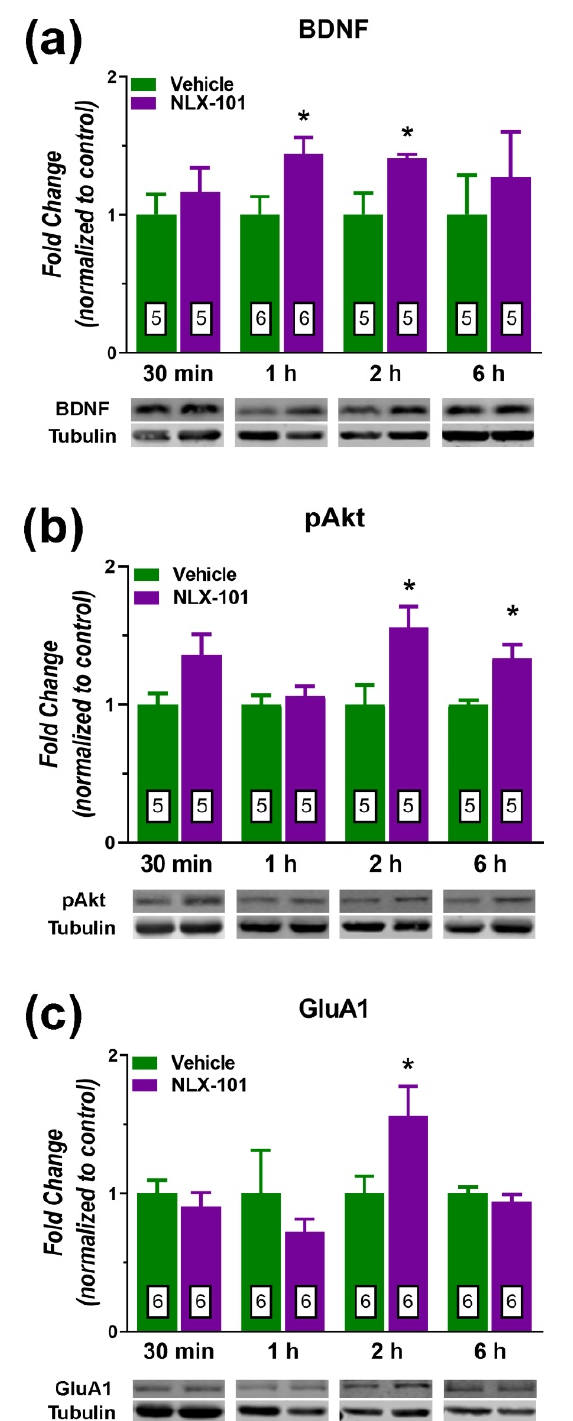
Figure 6. Effects of NLX-101 (0.16 mg/kg) and vehicle (Veh) on the concentration of BDNF ( a ), pAkt ( b ) and GluA1 ( c ) in the prefrontal cortex at 30 min, 1 h, 2 h and 6 h after its intraperitoneal admin- istration. Results are expressed as mean ± SEM. Number of animals is indicated within the bars. * p < 0.05 compared with the corresponding vehicle group (two-tailed Student’s t -test).